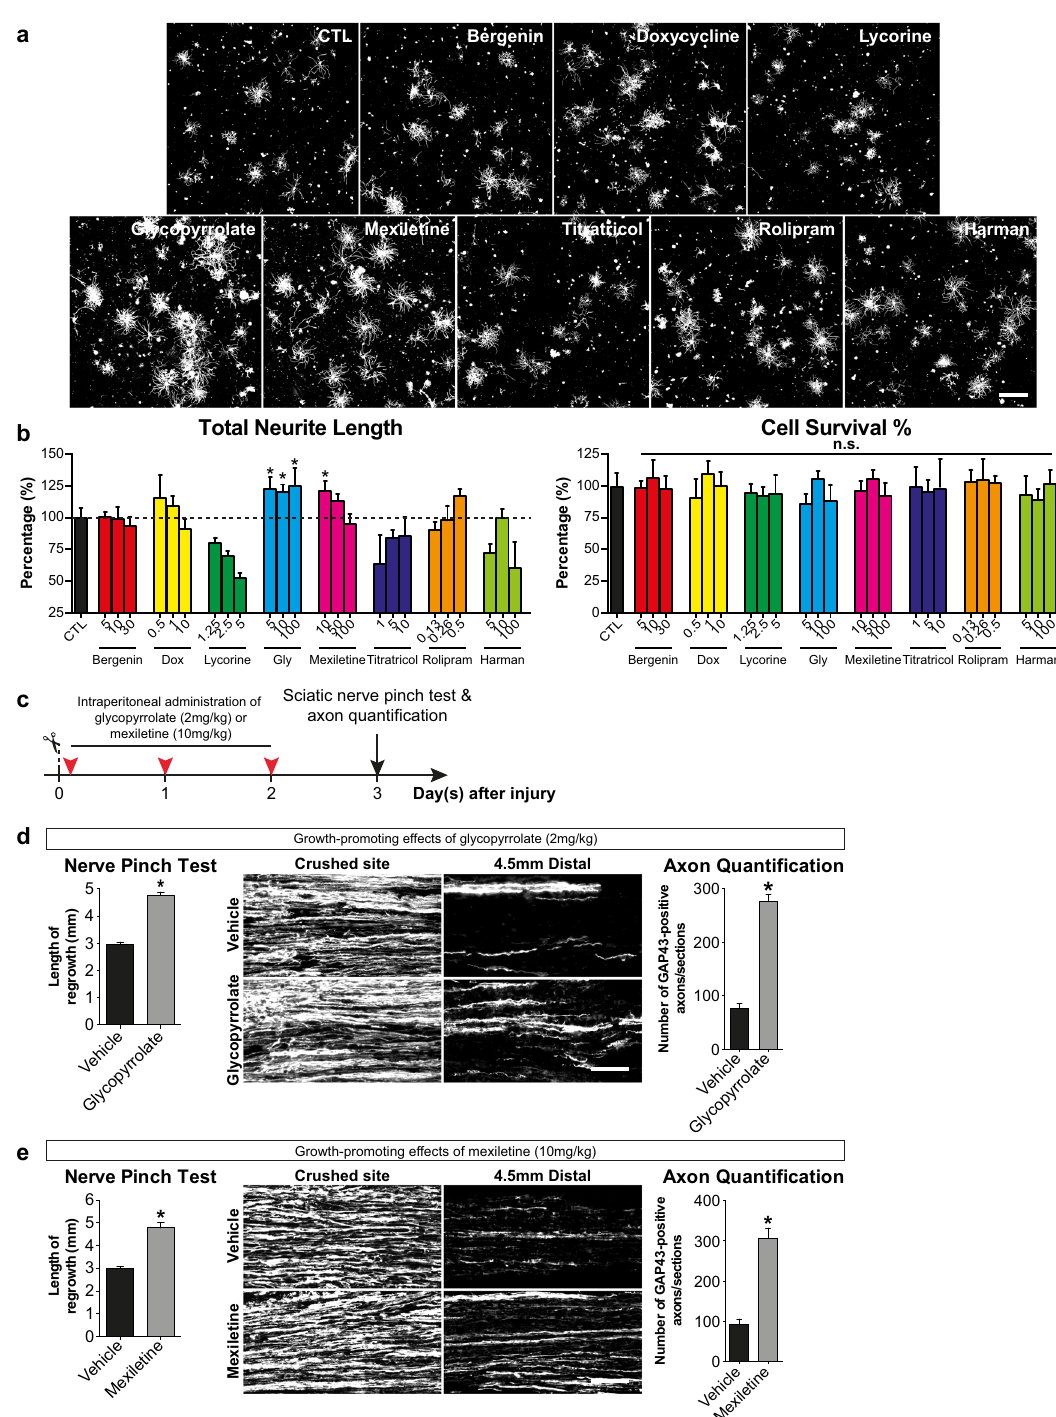
Fig. 6 FDA-approved small molecules glycopyrrolate and mexiletine increase the intrinsic growth capacity of axotomized dorsal root ganglion (DRG) neurons, and promote in vivo axon regeneration after sciatic nerve crush injury. a , b Primary DRG cultures were prepared from adult male C57BL/6 mice, and treated with top-ranked small molecules at various concentrations. DMSO (0.1%) was used as solvent control. Glycopyrrolate and mexiletine induced maximal neurite outgrowth of DRG neurons, when compared with solvent controls. Cell survival assay was performed by WST-1 cell survival assay. All tested small molecules did not exhibit any adverse cell survival effect on DRG neurons. Scale bar: 500 µm. Mean ± SEM of triplicates. c Schematic diagram illustrating the experimental paradigm for sciatic nerve pinch test. We performed nerve pinch test in adult mice injected intraperitoneally with glycopyrrolate (2 mg/kg) or mexiletine (10 mg/kg) for 3 consecutive days after injury. d, e Both glycopyrrolate ( d ) and mexiletine ( e ) markedly accelerated in vivo axon regeneration after sciatic nerve crush injury as assessed by sciatic nerve pinch tests. The most distal axonal regrowth in mice treated with glycopyrrolate and mexiletine was increased signi fi cantly by 61 and 59%, respectively. The number of GAP43-positive regenerating axons were increased by 73% in glycopyrrolate-treated mice and 67% in mexiletine-treated mice. Scale bar: 100 µm. Mean ± SEM ( n = 5 – 6 per group); * P < 0.05; one-way ANOVA followed by post hoc Bonferroni test in ( b ); Student ’ s t test in ( d , e